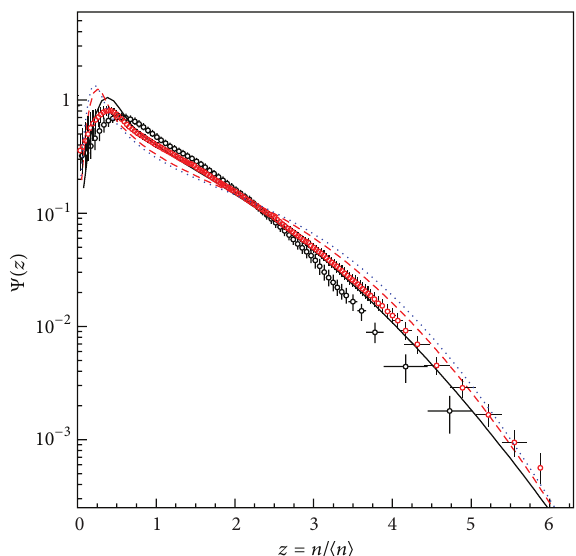
Figure 14: The charged hadron multiplicity distributions in KNO form at √𝑠 𝑁𝑁 = 0.9 TeV and 7TeV in pseudorapidity interval, |𝜂| < 0.5 along with comparison to the experimental data. The figure is taken from